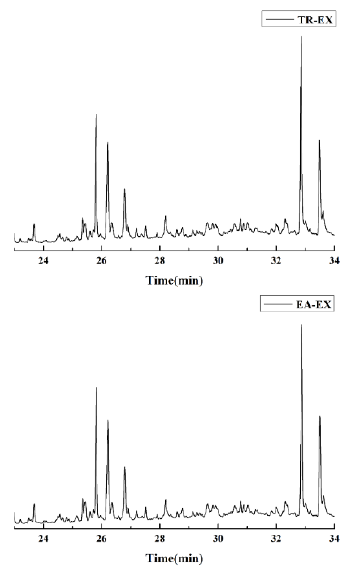
Figure 1. Gas chromatography-mass spectrometry (GC-MS) chromatograms of ethyl acetate extracts (EA-EX) and trichloromethane extracts (TR-EX) from Phoebe zhennan wood residues.